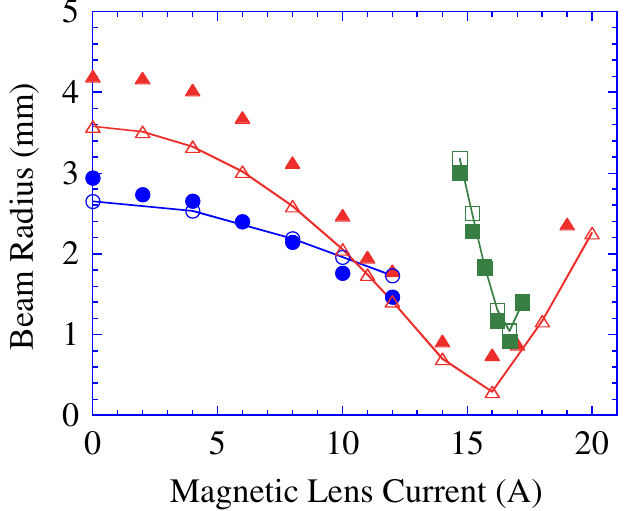
FIG. 4. (Color) Measured beam-size dependences on the mag- netic lens strengths compared with the PARMELA code. The filled and open symbols represent measured and numerically fitted data, respectively. The squares show the dependence on the strength of the 1st magnetic lens (ML) at the collimator right after the deflector. The triangles (circles) show the dependence on strength of the 3rd (6th) ML at the 1st (2nd) profile monitor.